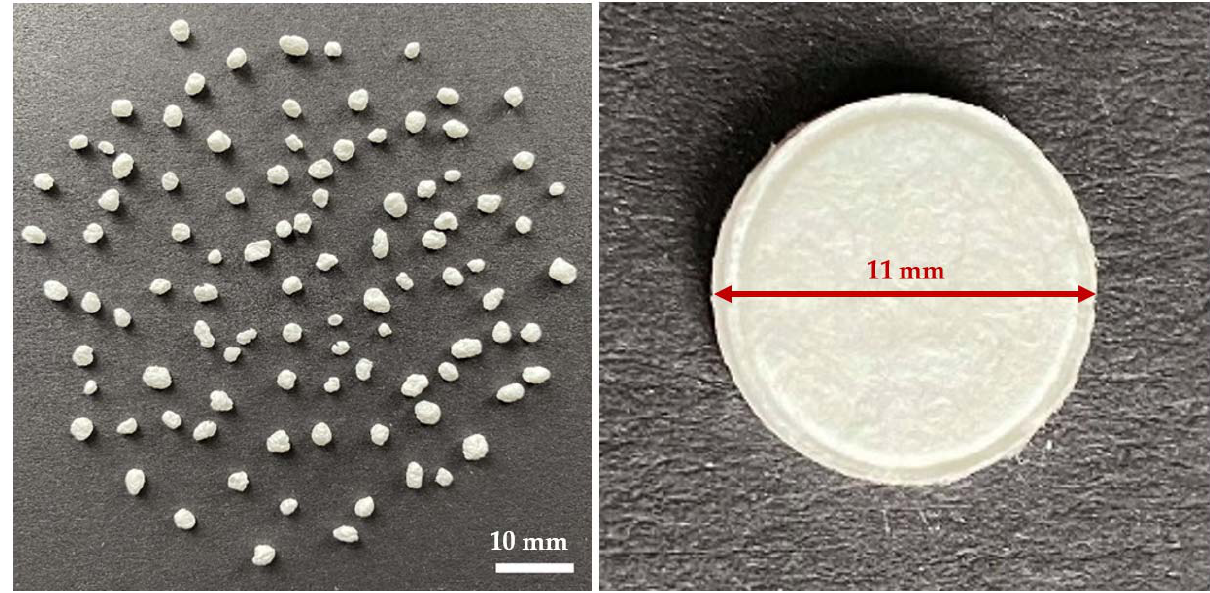
Figure 2. Paper granules with 20% sucrose content (B3) and the produced tablet made from the B3 paper granules. Table 3. Physico ‐ chemical properties of the different paper granules produced in this study.